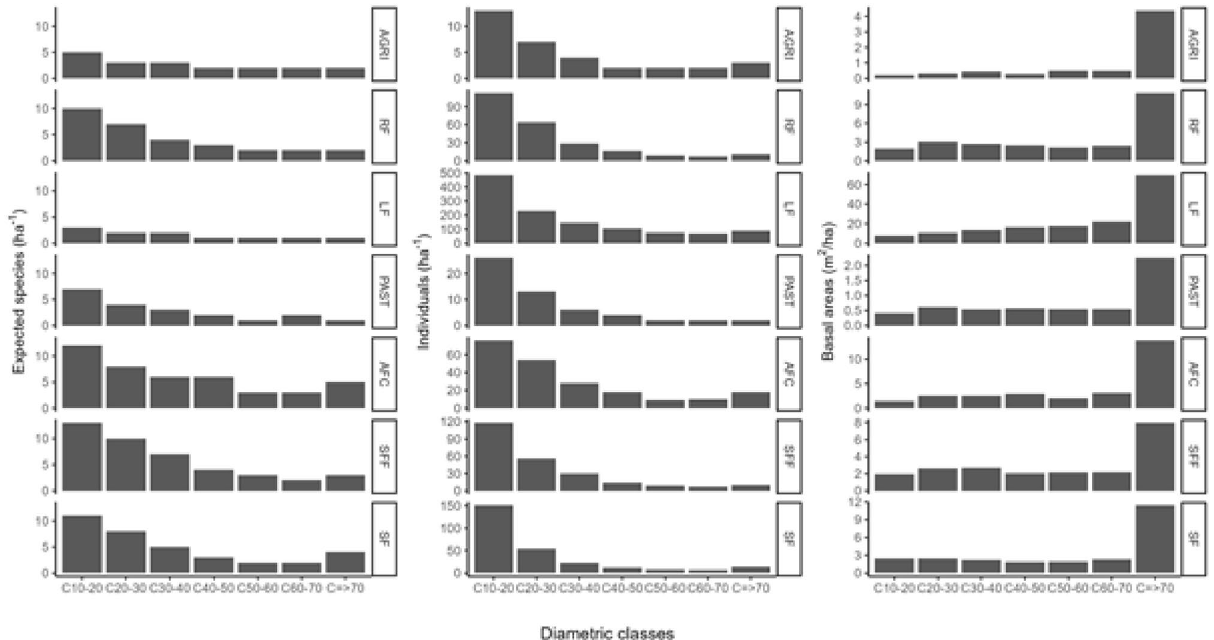
Figure 3. Diameter class distributions for expected species density (first column), tree density (second column) and basal areas (third column) for each land use. The three metrics are standardized per hectare. The different land uses are secondary forest (SF), secondary forest fragment (SFF), agroforestry coffee (AFC), agriculture (AGRI) and pastures (PAST), live fences (LF) and riparian forest showed the lowest average values of 0 D. For the effective average number of common species ( 1 D), agroforestry coffee showed greater diversity than the other uses, and live fences and pasture the lowest values. Forests (sec- ondary, secondary fragments and riparian) and agriculture did not differ from each other in the average value of 1 D. The diversity of dominant species ( 2 D) was higher in agriculture than in other land uses. Live fences and pasture presented the lowest diversity value for dominant species (Fig. 5).